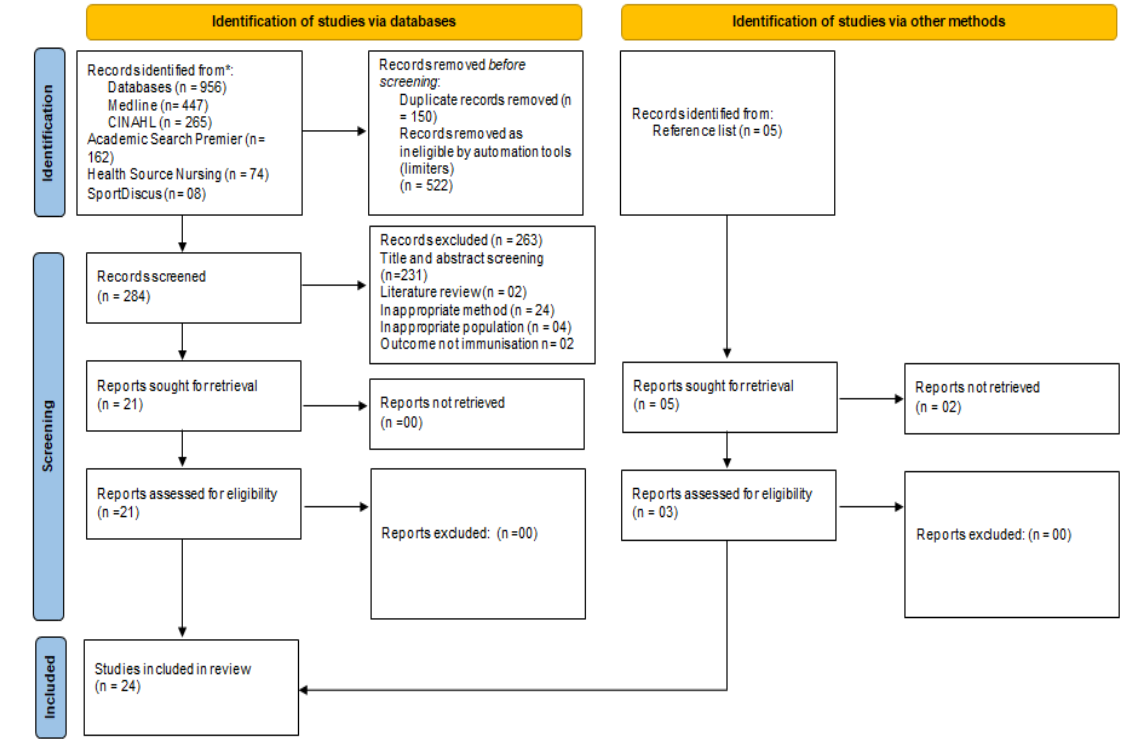
Figure 1. PRISMA flow chart .